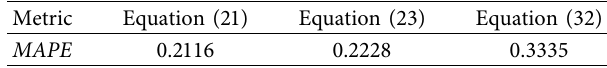
Figure 3: Relative errors of the permeability values, where ε ∗ , ε , ε experimental permeability K e , respectively. Table 4: Statistical analysis of the prediction precision of the permeability listed in Table